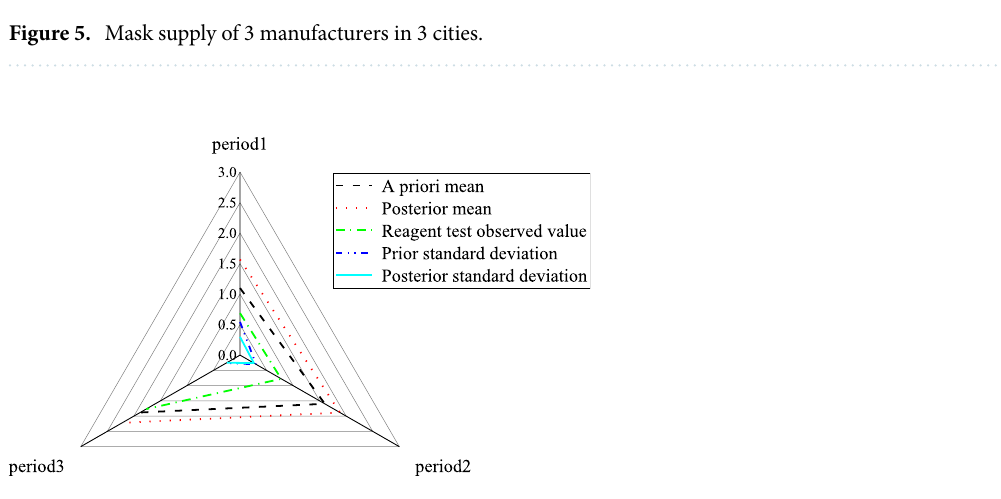
Figure 6. Statistics of infection